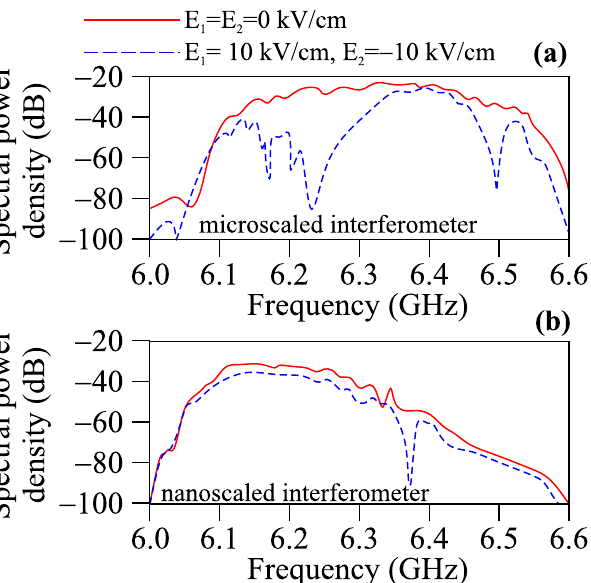
Figure 3. Frequency dependencies of spectral power density for micro-scaled ( a ) and nano-scaled ( b ) MZI in the case of different values of E